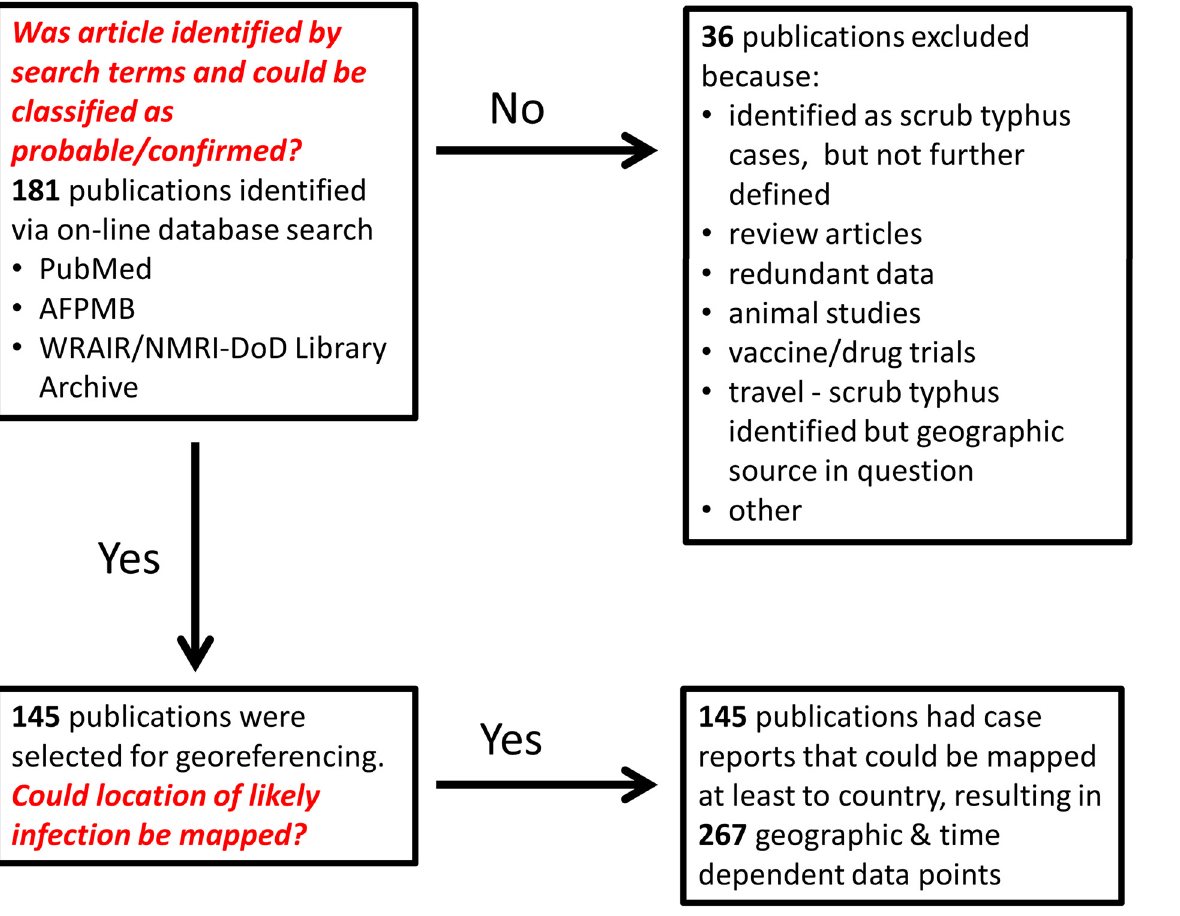
Fig 2. Flow chart used for scrub typhus case literature